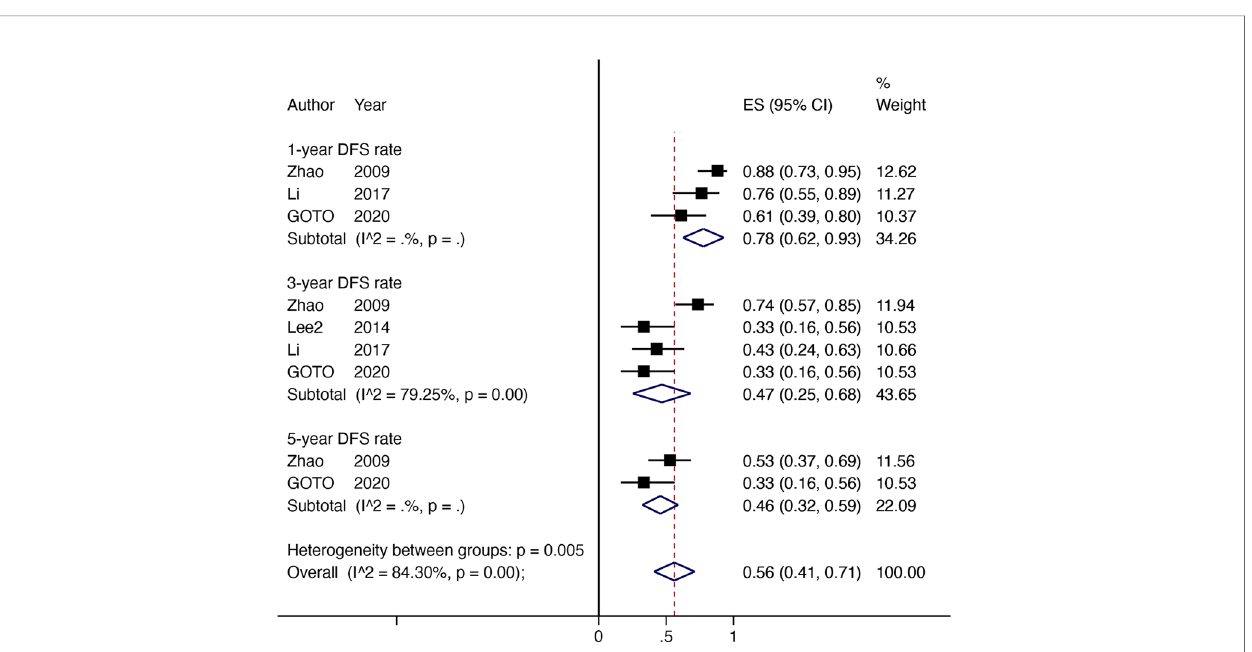
FIGURE 3 | The DFS rate for HR with downstaging therapies in patients with